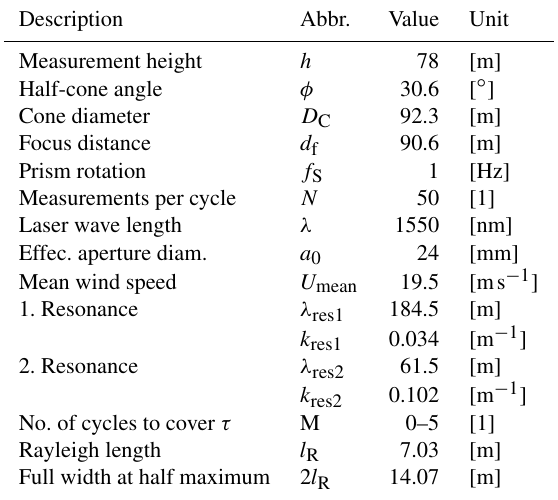
Table 1. Key specifications of the lidar used in the measurements.